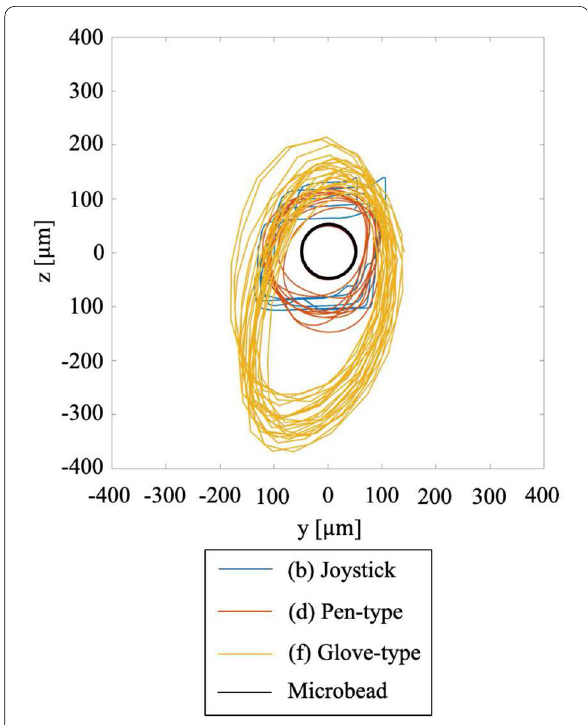
Fig. 17 Trajectories in the yz -plane with 3D image presentation in the evaluation of operation speed